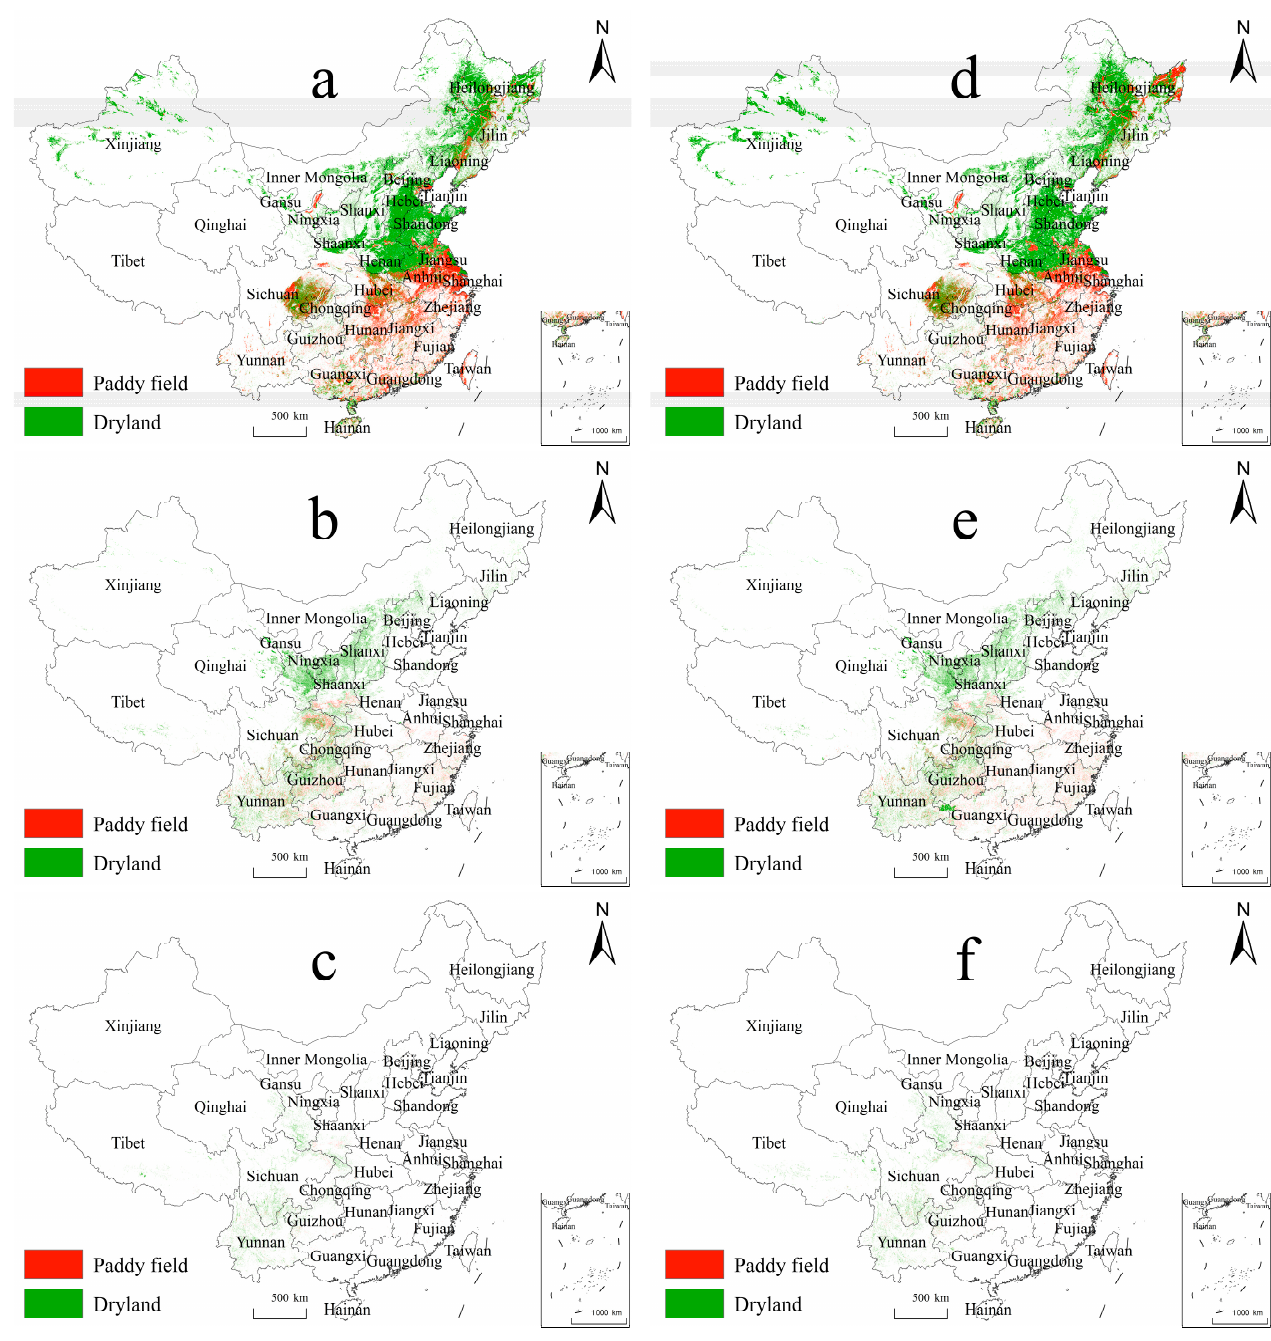
Figure 1. Distribution of paddy field and dryland under different TPIs in China in 1990 and 2020. (( a ), low (<0.4) TPI in 1990; ( b ), medium (0.4–0.8) TPI in 1990; ( c ), high (>0.8) TPI in 1990; ( d ), low (<0.4) TPI in 2020; ( e ), medium (0.4–0.8) TPI in 2020; ( f ), high (>0.8) TPI in 2020). From the perspective of elevation (Figure 2), 40% of the drylands and 64% of paddy fields were distributed at 0–200 m elevation, which decreased over time. The dryland area was greater than that of paddy field at the same elevation. From 1990 to 2020, the most obvious change in dryland and paddy field was concentrated at an elevation of 0–200 m. When looking at the change in dryland, this study found that the dryland increased in all elevations except for 0–200 m, with the highest annual growth rate (1.01%) in the >3500 m elevation area and the lowest annual growth rate (0.03%) in the 1500–2500 m elevation area. When looking at the change in paddy field, the results showed that the paddy field